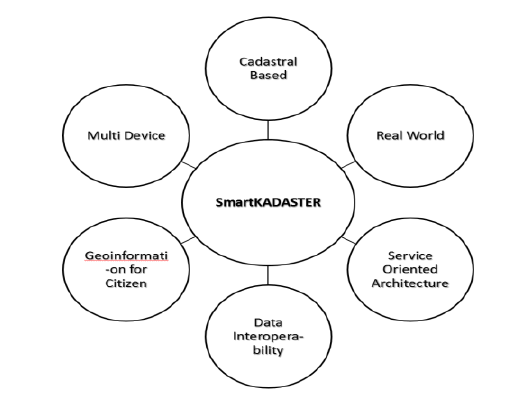
Figure 1 Characteristics of SmartKADASTER